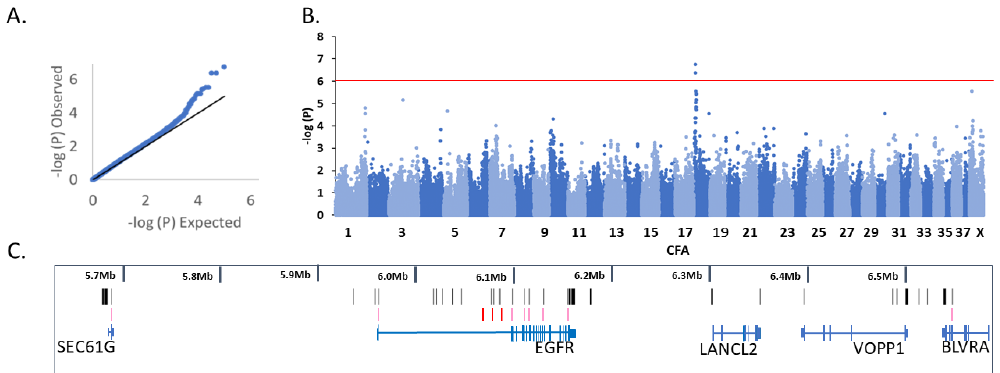
Figure 2. Genome-wide association analysis for Chronic Superficial Keratitis in Australian racing greyhounds (Cases 66, Controls 39). ( A ) Quantile-quantile plot. ( B ) Manhattan plot (Lamda = 1.14). ( C ) Genes in the association region showing the three genome-wide significant markers (BICF2P579527, CFA18: 6,068,508, p raw = 1.77 × 10 − 7 , p genome = 0.017; BICF2P1310662, CFA18: 6,077,388, p raw = 4.09 × 10 − 7 , p genome = 0.040; BICF2P160719, CFA18: 6,087,347, p raw = 4.09 × 10 − 7 , p genome = 0.040)) as red bars. Putative functional variants in exons and splice-sites are shown as pink bars. All possible functional variants including variants in UTRs and non-coding RNAs shown as black bars. All positions refer to